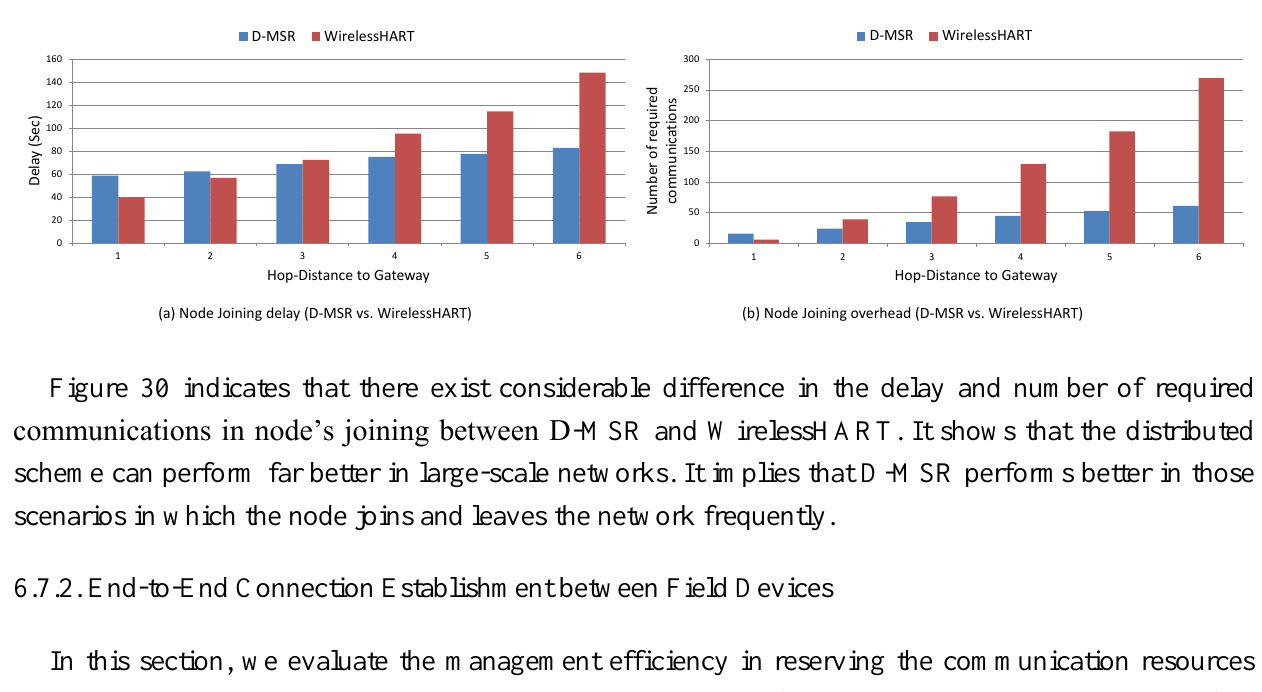
Figure 30. Nodes joining delay ( a ) and overhead ( b ) (D-MSR vs.